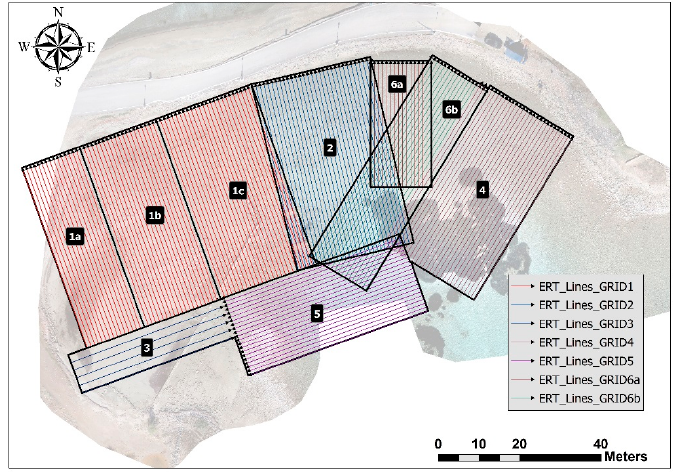
Figure 7. Layout of the grids and the individual electrical resistivity tomography (ERT) lines used to cover the southern bay in Olous. cover the southern bay in